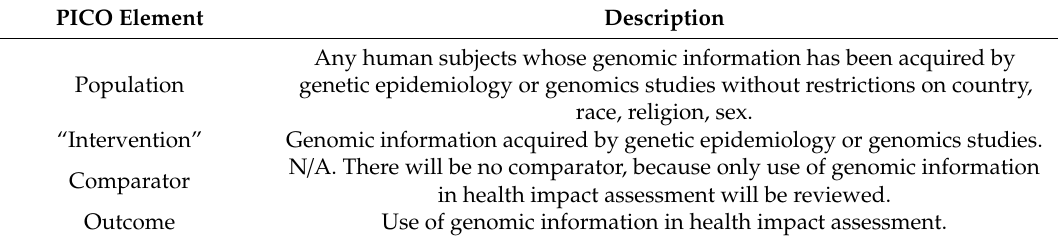
Table 1. PICO (population, intervention, comparator, outcome) statement. PICO Element Description Any human subjects whose genomic information has been acquired by Population genetic epidemiology or genomics studies without restrictions on country, race, religion, sex. “Intervention” Genomic information acquired by genetic epidemiology or genomics studies. N / A. There will be no comparator, because only use of genomic information Comparator in health impact assessment will be reviewed. Outcome Use of genomic information in health impact